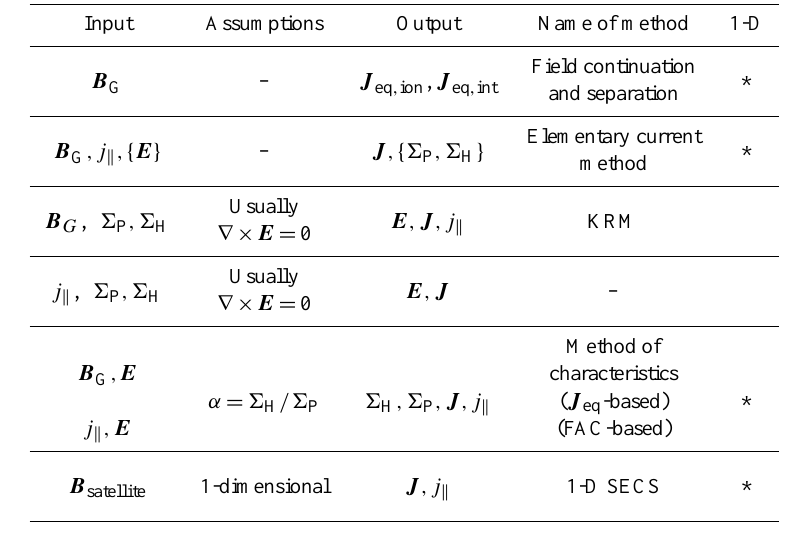
Table 1. Overview of selected analysis